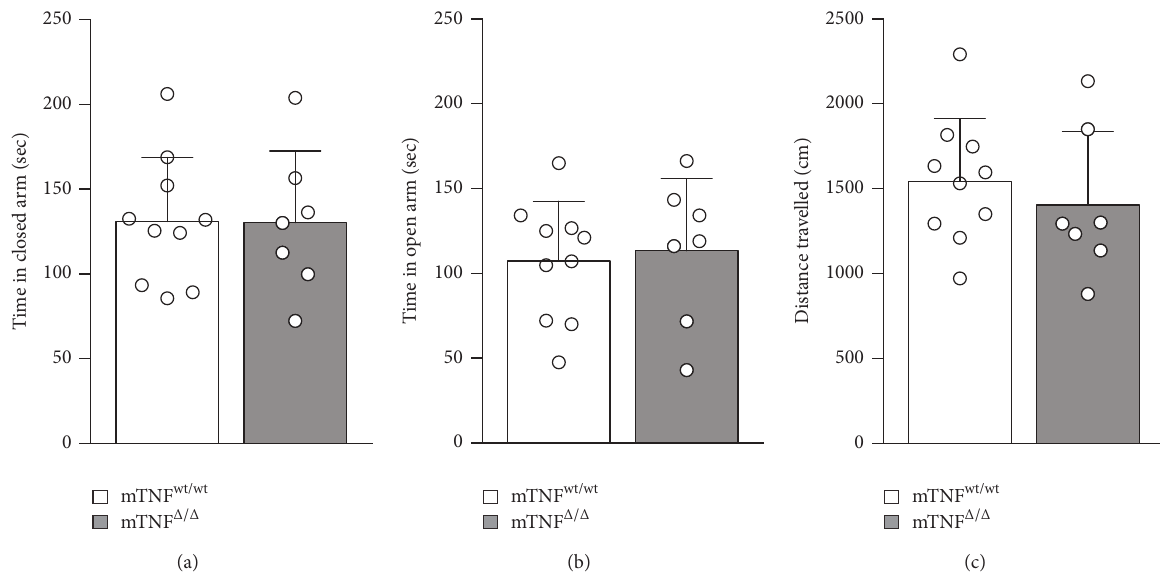
Figure 1: Elevated plus maze analysis in na¨ıve mTNF wt / wt and mTNF Δ/Δ mice. (a–c) mTNF wt / wt and mTNF Δ/Δ mice spent comparable times in the closed arm (a) and the open arm (b) and travelled a similar distance (c) in the elevated plus maze test. Mann–Whitney test, 𝑛 = 7 – 10mice/group. Results are presented as mean ±